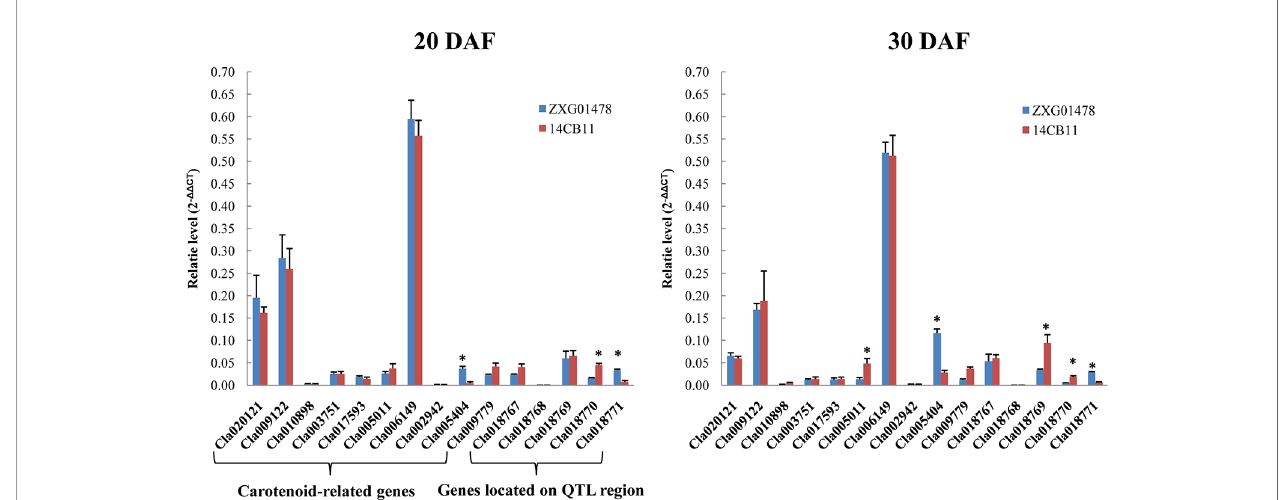
FIGURE 4 | The expression pro fi les of carotenoid-related genes and potential candidate genes in fl esh at different developmental stages using quantitative real-time polymerase chain reaction (qRT-PCR). DAF is the abbreviation for days after fl owering. Watermelon actin was used as an internal control. Data are expressed as the means of the three biological replicates; error bars indicates SDs; ** indicates signi fi cance at p <